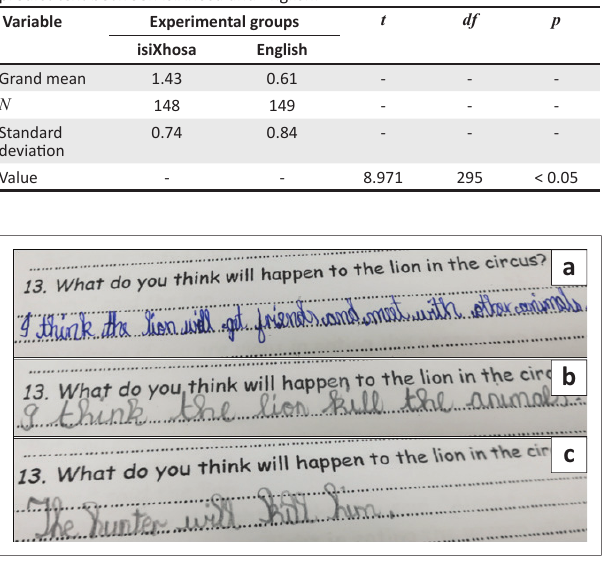
FIGURE 1: (a–c) Learner responses to a text prediction question.